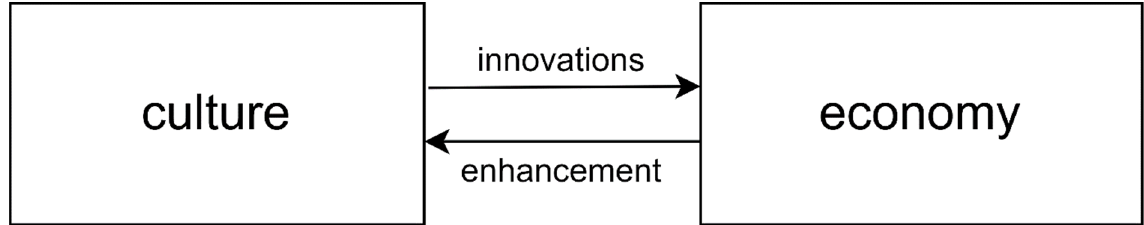
Figure 1. The relationship between culture and economy. Source: own study based on (Klasik 2010, p. 7).